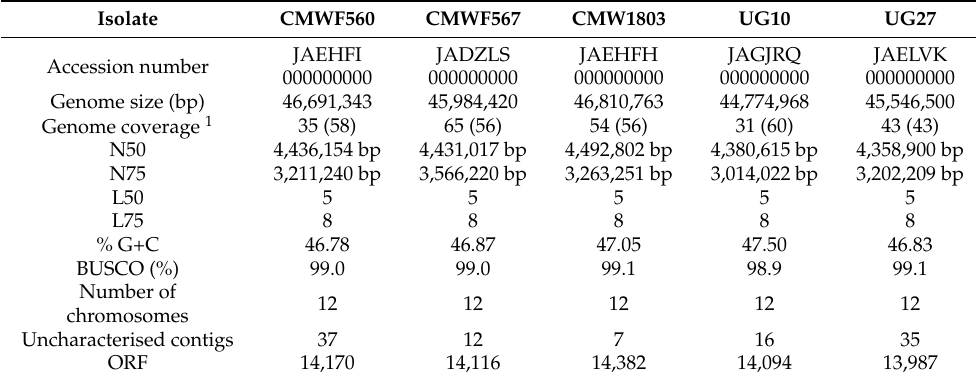
Table 1. Summary of whole nuclear genome assembly